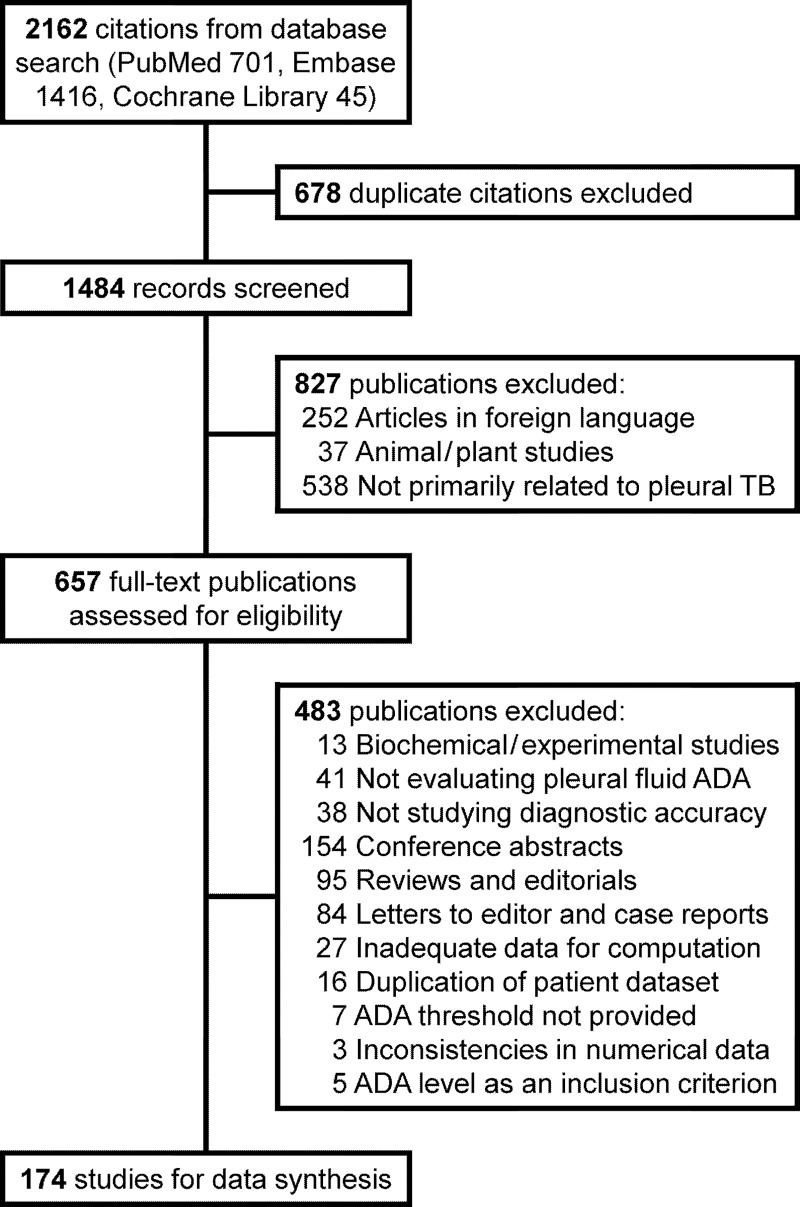
Study selection process.